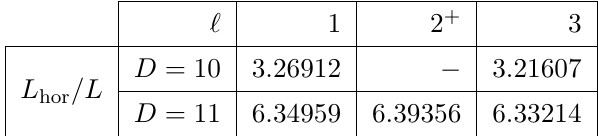
Figure 10. Lumpiness parameter λ and minimum radius of the S p − 2 , min [ R p − 2 ( a )] , for the ‘ = 1 family of lumpy black holes as a function of the dimensionless temperature for the ( p, q ) = (5 , 5) (left) and ( p, q ) = (4 , 7) (right) cases. These plots show that λ diverges as we approach the merger point. Lumpy black hole families labelled by other harmonics ‘ exhibit a qualitatively similar behavior.